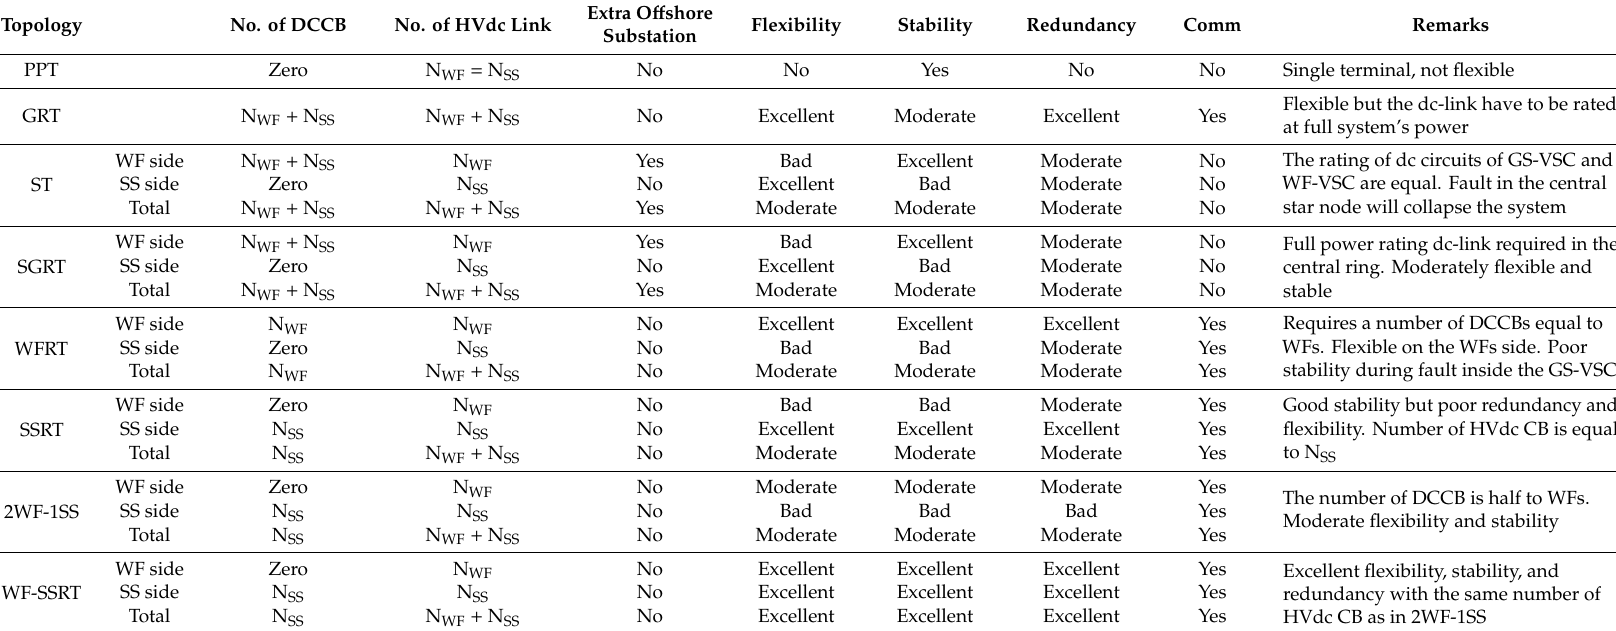
Table 4. Comparison of MT-HVdc system